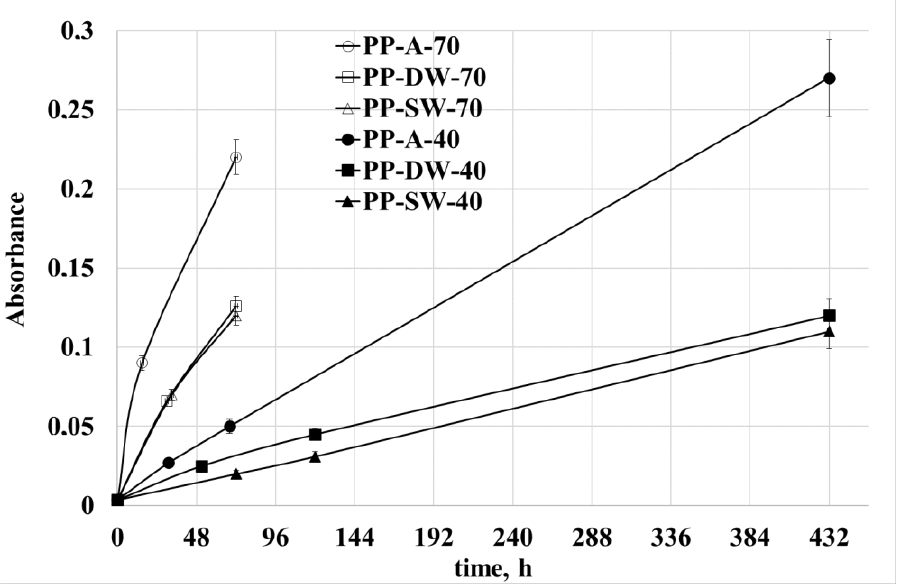
Figure 5. Peak height at 1720 cm − 1 at 40 °C and 70 °C.